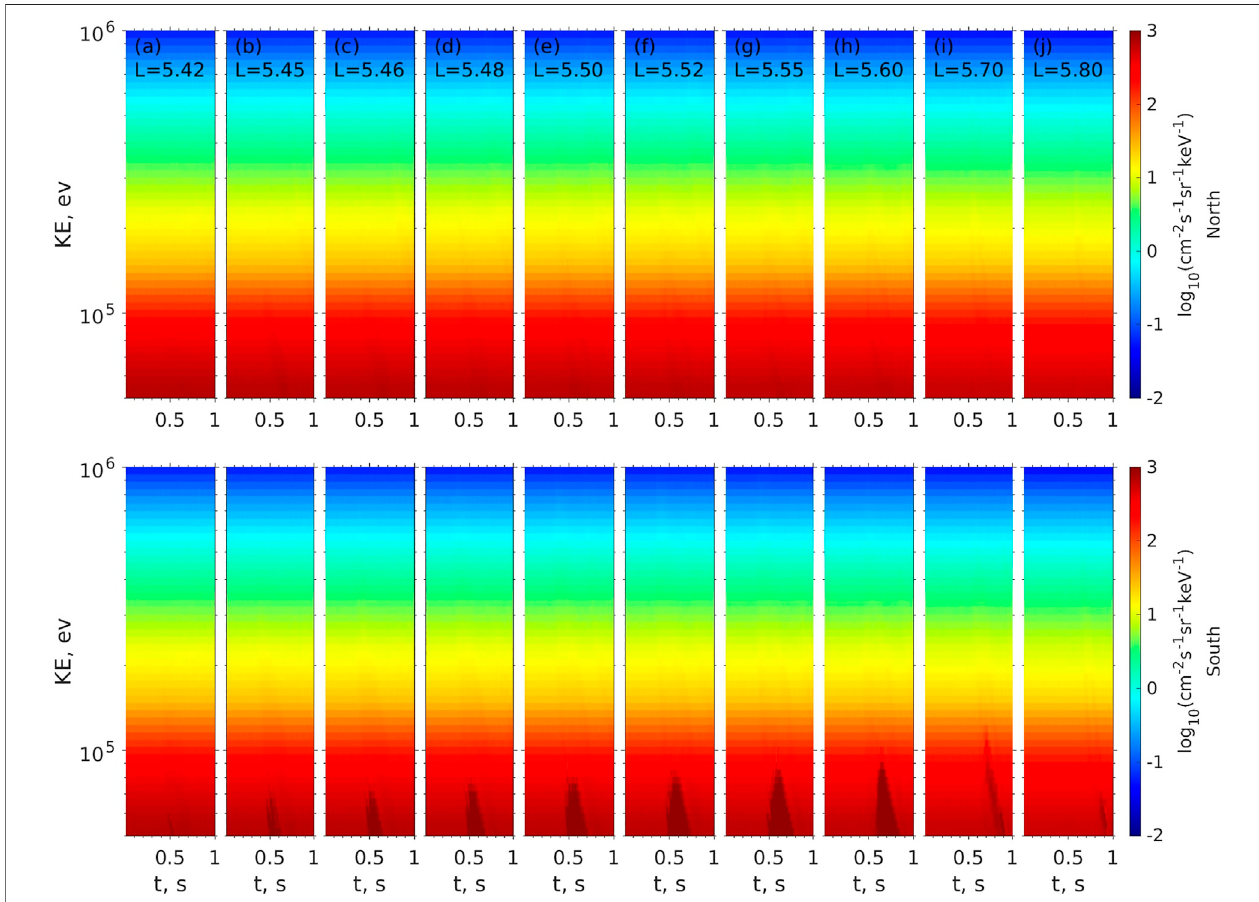
FIGURE 6 | Modeled electron fl uxes at virtual northern (top panels) and southern (bottom panels) LEO satellites due to the presence of the nonducted wave shown in Figure 5 at selected fi eld lines with L values from 5.42 to 5.80 (A – J)